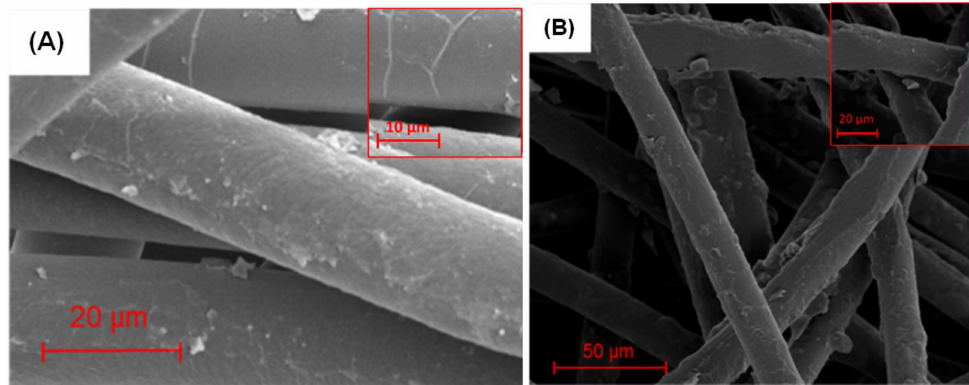
Figure 5. Scanning electron microscopy (SEM) of ( A ) uncoated fabric ( B ) fabric coated with